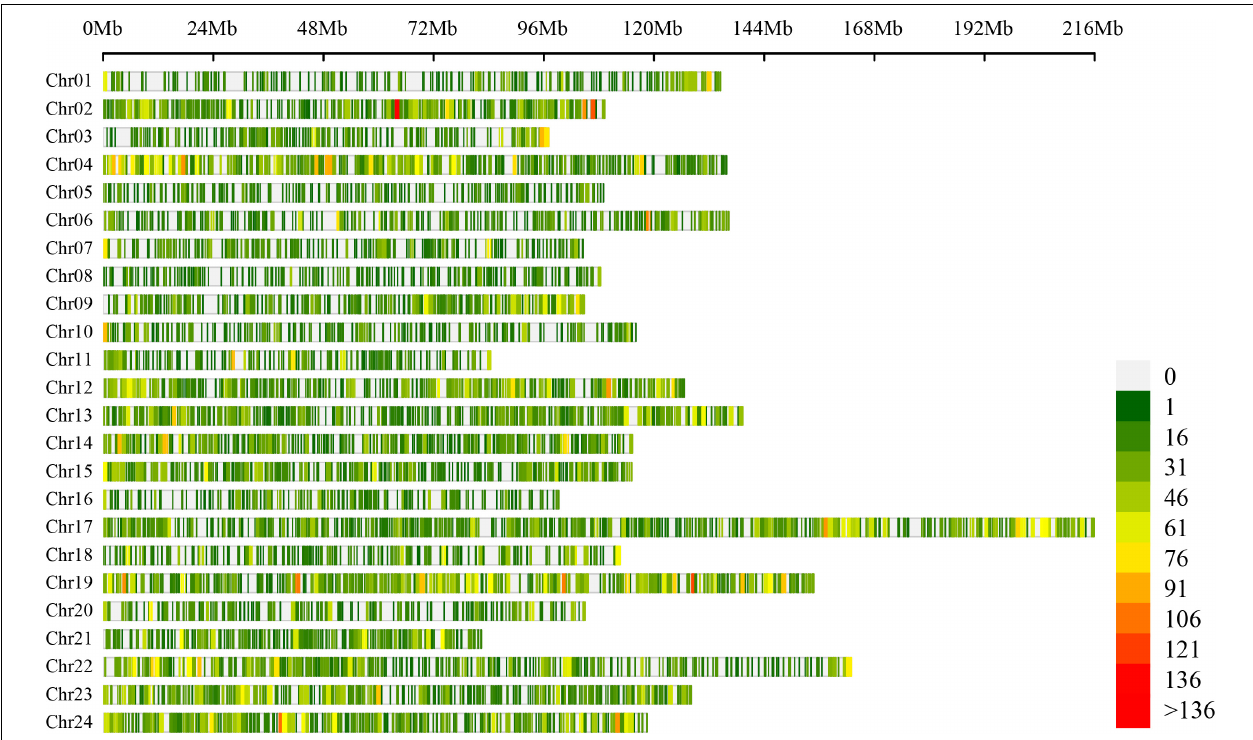
FIGURE 2 | Chromosome distribution of AS events in tobacco genome. Figures on the right hand of the color bar indicated the number of AS events within the 1 Mb window size. Chr: chromosome.